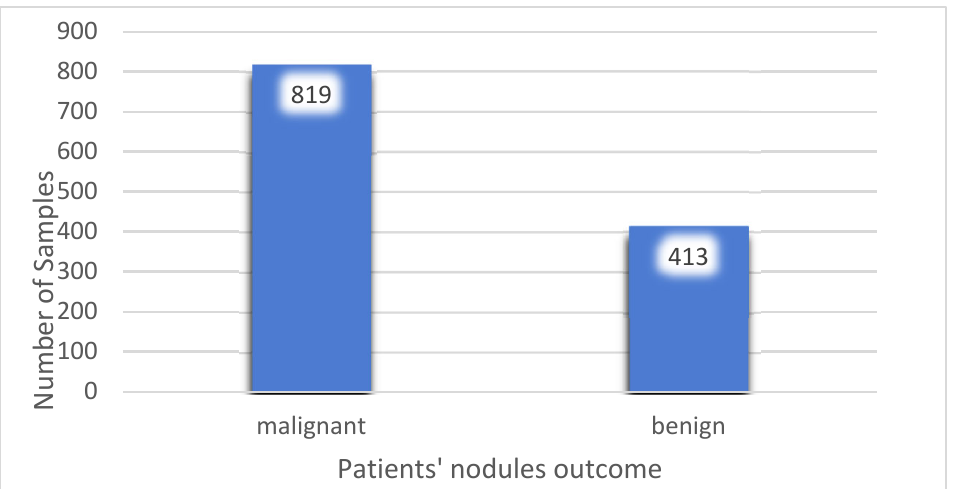
Figure 1. The number of nodules samples per outcome. The ages of the patients ranged from 13 to 82, and the mean age was 46.6. Figure 2 is a representation of the nodule data binned by patient ages, while in Figure 3 the data are binned according to patient age and nodule malignancy, and in Figure 4 the nodules are also binned by patient data. These plots demonstrate that the modal age group was 43–52 and that there were far more nodules from female patients (1032) than male patients (200). Figure 5 shows the correlation values for all 19 features, and it shows a significant correlation between the nodule outcome and four features: site, shape, calcification, blood flow, and margin.